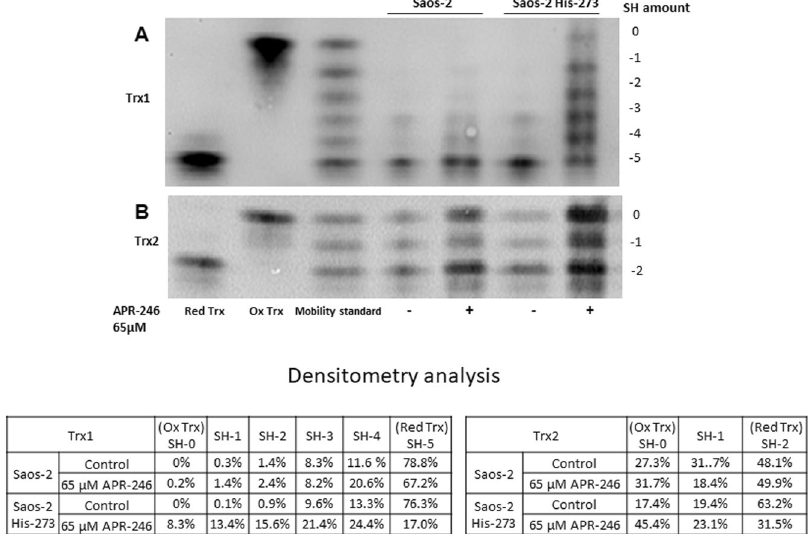
Figure 4. Effects of APR-246 on redox status of Trx1 and Trx2 in Saos-2 and Saos-2 His-273 cells. p53 null Saos-2 and mutant p53-expressing Saos-2-His-273 cells were treated with 65 µ M APR-246 for 24 hours. The redox states of Trx1 (upper) and Trx2 (lower) were detected with a redox Western blotting method (two separated gels, original picture see Supplementary Fig. S2). The table shows the percentage of adjusted volume of each band for respective treatment groups.